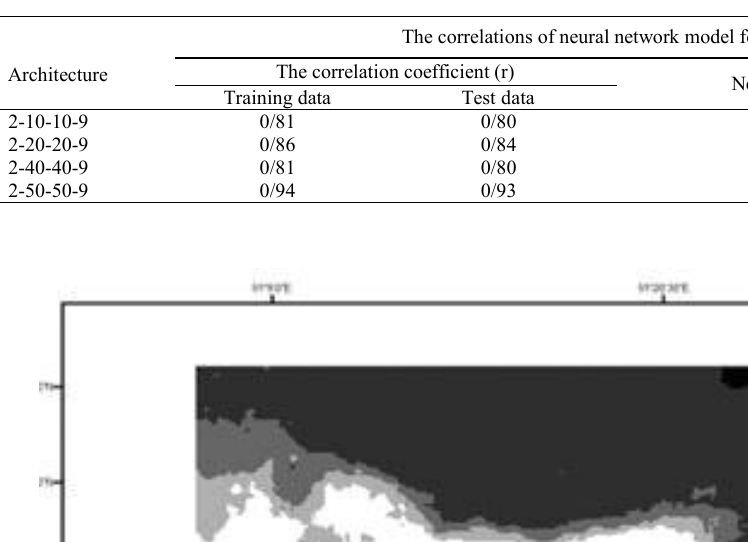
Table 1: The correlation of different network